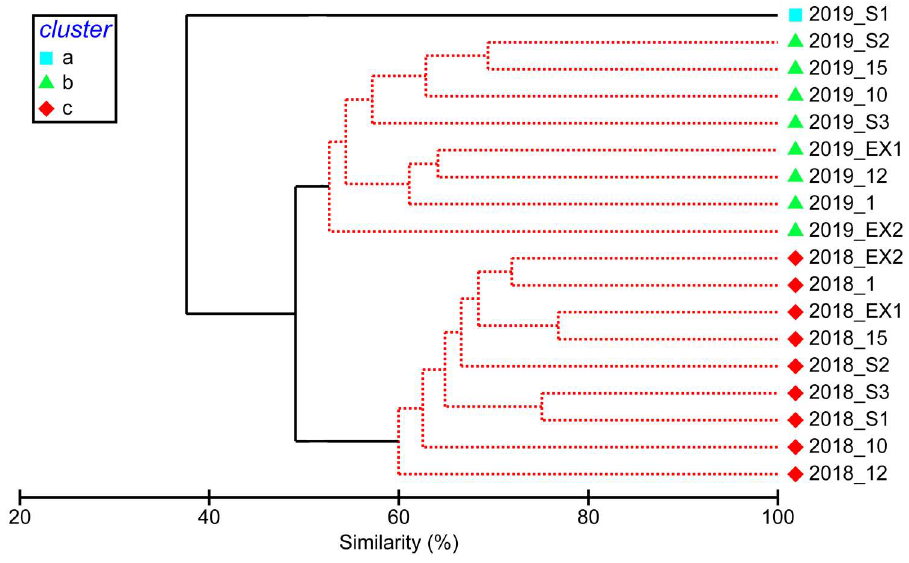
Figure 4. The results of the cluster analysis of the copepod community in each sample, measured by Bray-Curtis similarity distances.